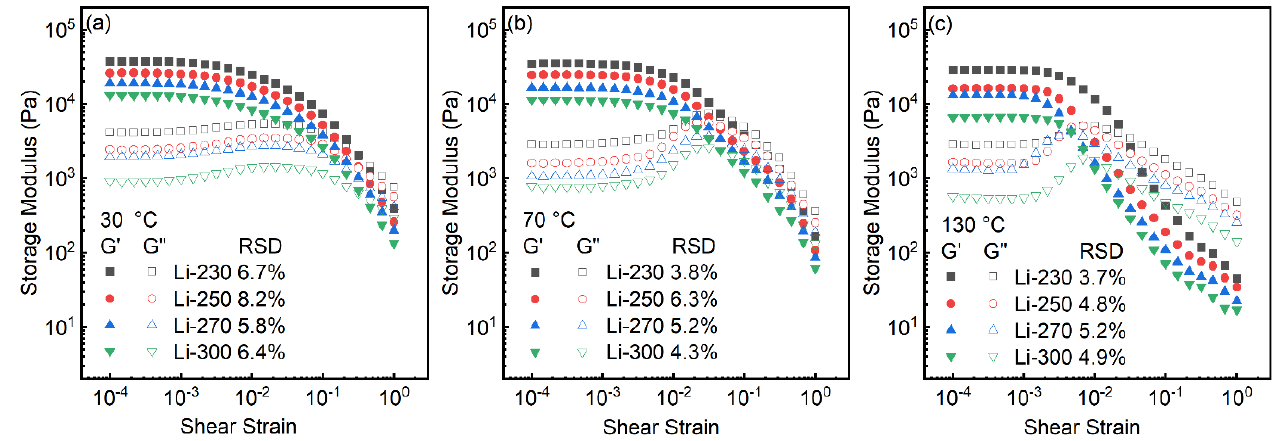
Figure 7. Strain-scanning curves of lithium grease with different consistencies at different tempera- tures: ( a ) 30 °C, ( b ) 70 °C, ( c ) 130 °C.